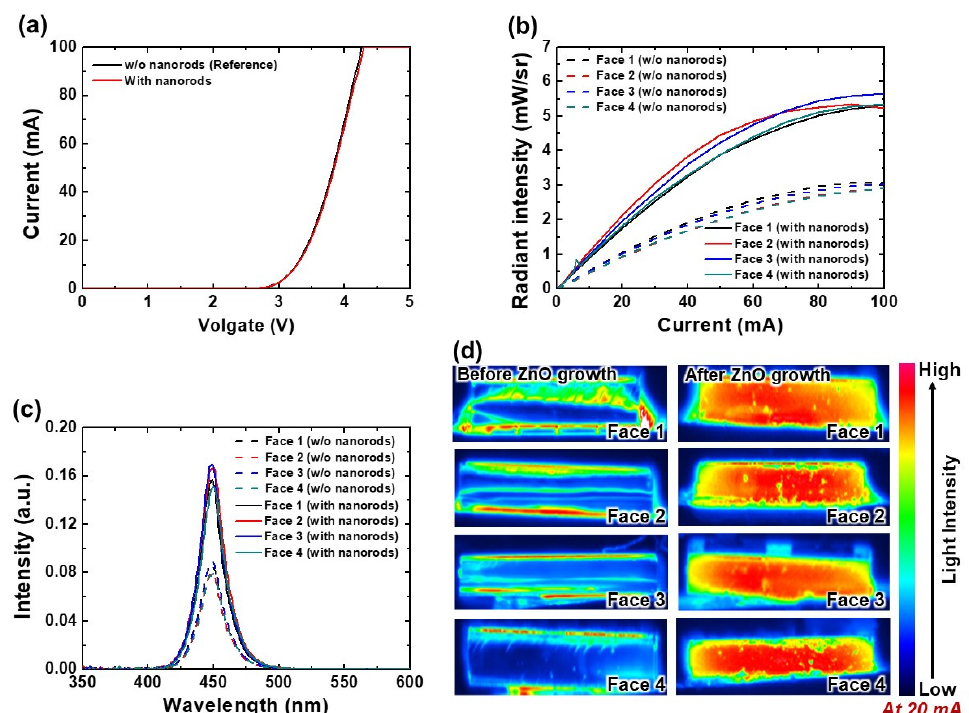
Figure 7. ( a ) I-V and, ( b ) LOP characteristics of reference and optimized ZnO nanorods USE-LEDs. ( c ) Peak amplitude of EL characteristics, and ( d ) EL intensity distribution over the sidewall area at 20 mA for reference and optimized ZnO nanorods USE-LEDs.